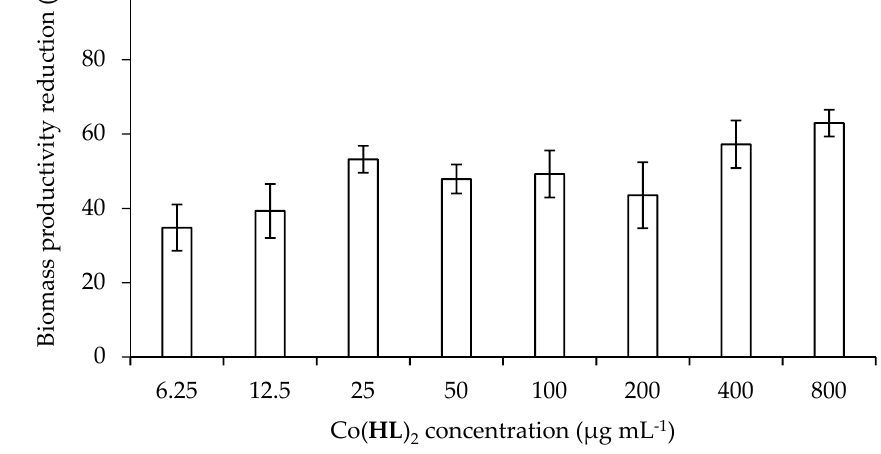
Figure 4. Preventive action of Co( HL ) 2 at MIC (800 µ g mL − 1 ) and sub-inhibitory concentrations (6.25 to 400 µ g mL − 1 ) on biomass productivity of P. aeruginosa PA14 (wild-type strain) biofilm. Mean values ± standard deviations for at least three replicates are illustrated.